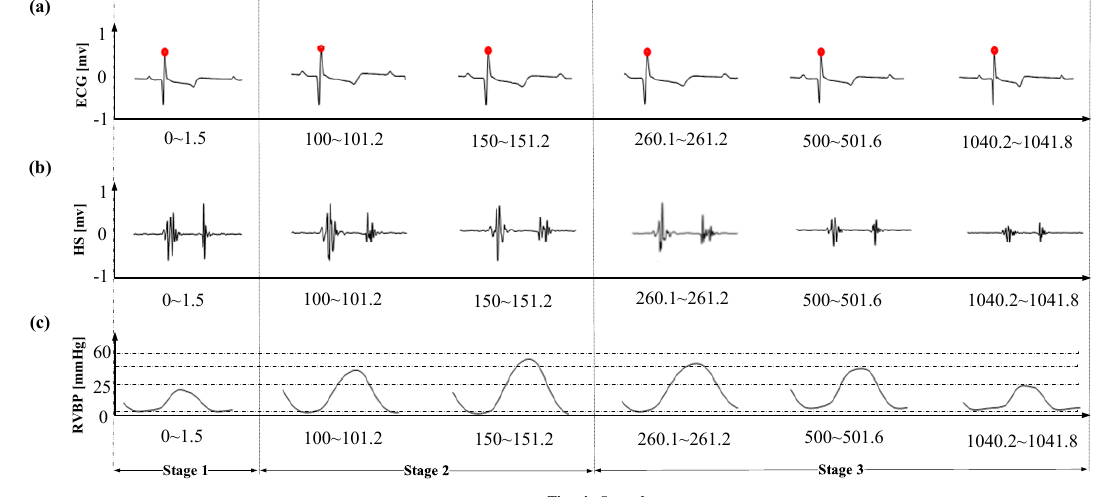
Figure 1. Schematic diagram of the measurement system and experimental procedure; ( a ) experiment setup; ( b ) experimental procedure. ECG: Electrocardiography; HS: Heart Sound ; RVBP: Right Ventricular Blood Pressure.